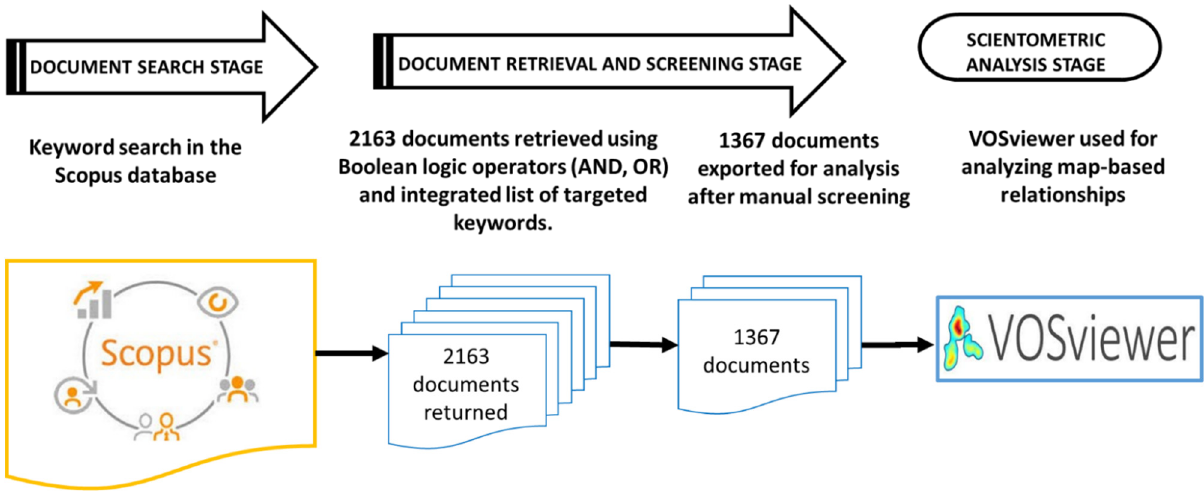
Figure 3. Overview of the Proposed Research Methodology for the Bibliometric Study.